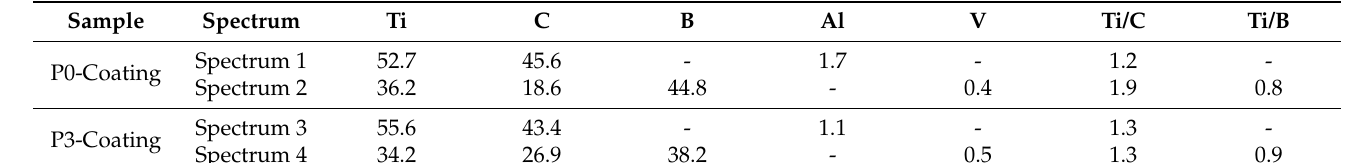
Figure 8. EDS spot scanning energy spectrum analysis results: ( a ) Spectrum 1 in Figure 7a, ( b ) Spec- Table 2. EDS spot scanning energy spectrum analysis results (Atomic%). Table 2. EDS spot scanning energy spectrum analysis results (Atomic%).